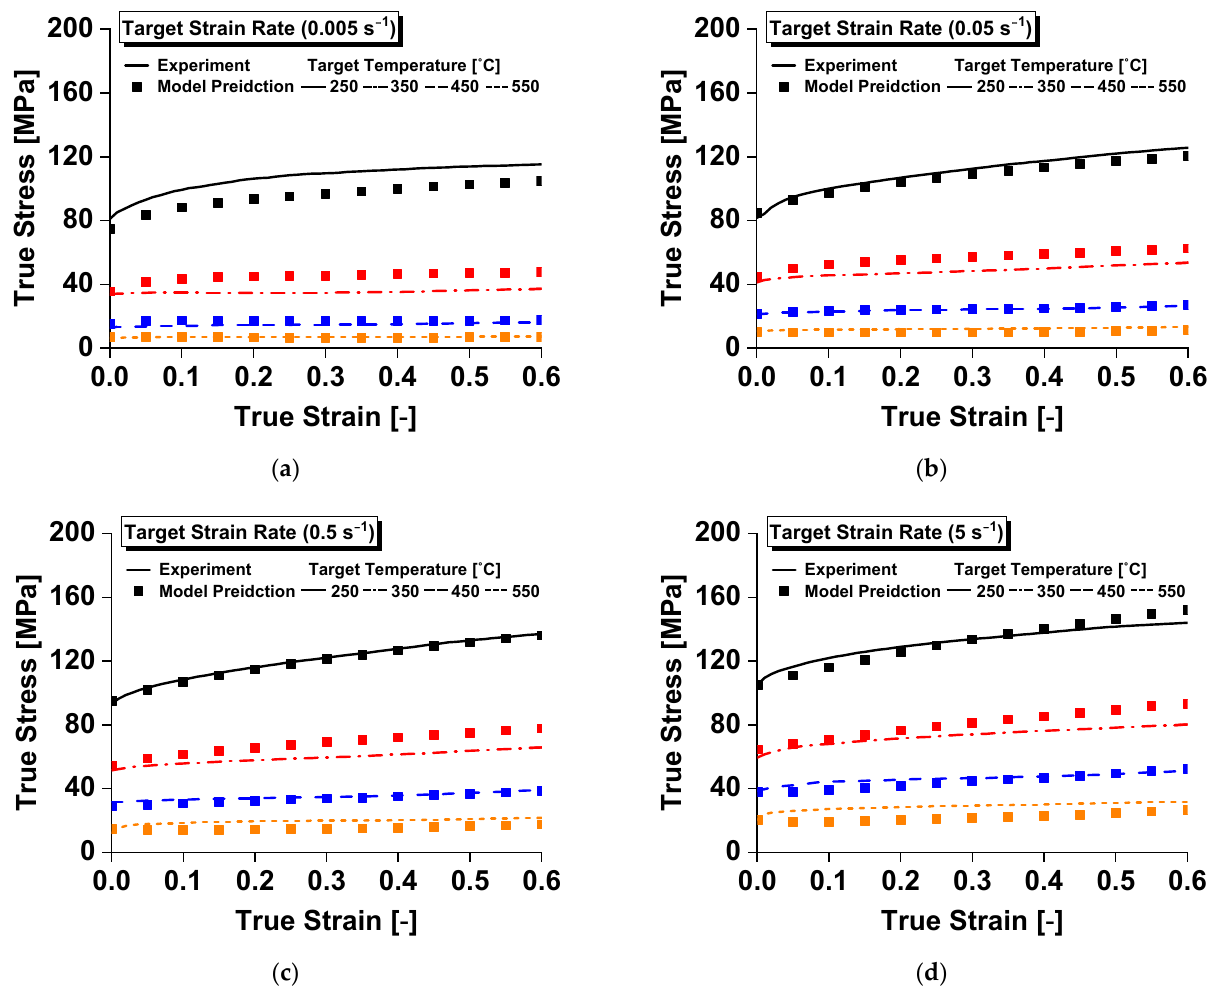
Figure 4. Temperature-dependent compressive yield stress of Al 6063 alloy at target strain rates of: ( a ) 0.005 s − 1 ; ( b ) 0.05 s − 1 ; ( c ) 0.5 s − 1 ; and ( d ) 5 s − 1 . A scatter plot of the Pearson correlation coefficient is presented in Figure 5.